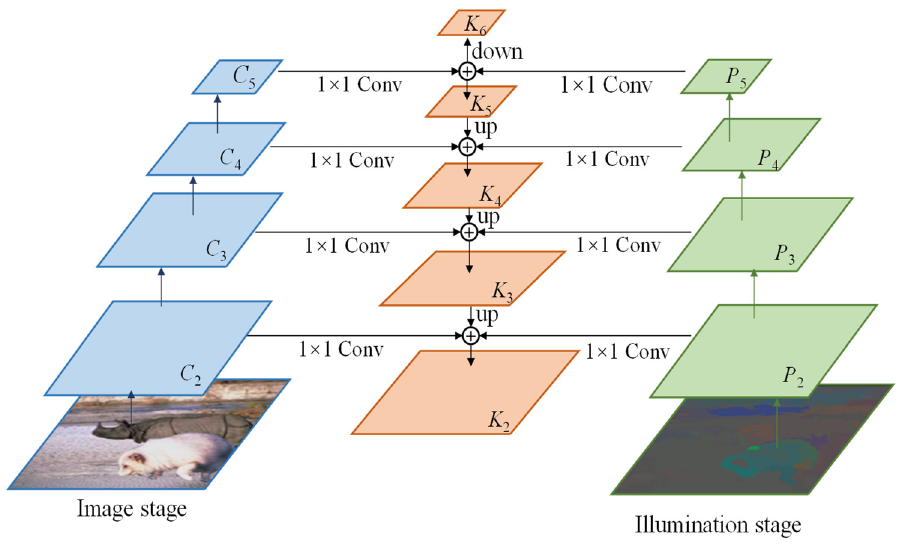
Figure 3. Multiple feature pyramid